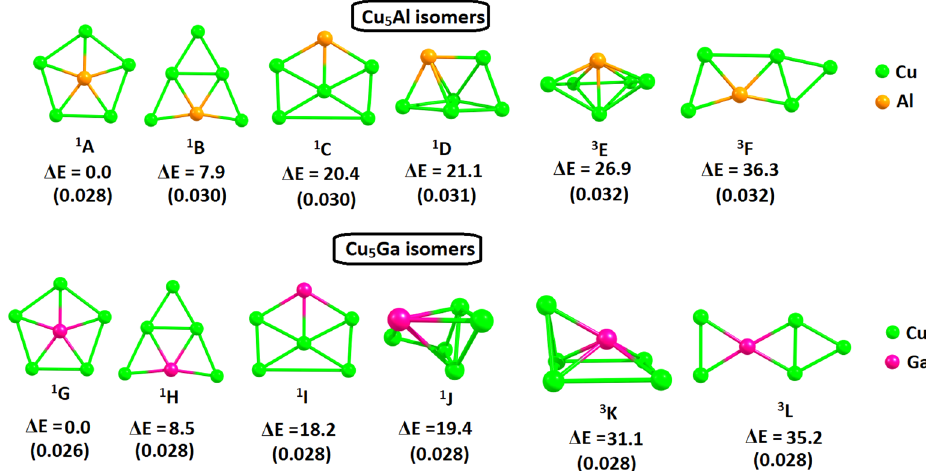
Figure 1. The relative energies in kcal/mol of the low energy isomers ( A – L ) of Cu 5 Al 2+ (top) and Cu 5 Ga 2+ (bottom) calculated at CCSD(T)/def2-TZVP//M06-2X/def2-TZVP level of theory. T 1 diagnostic values are given within